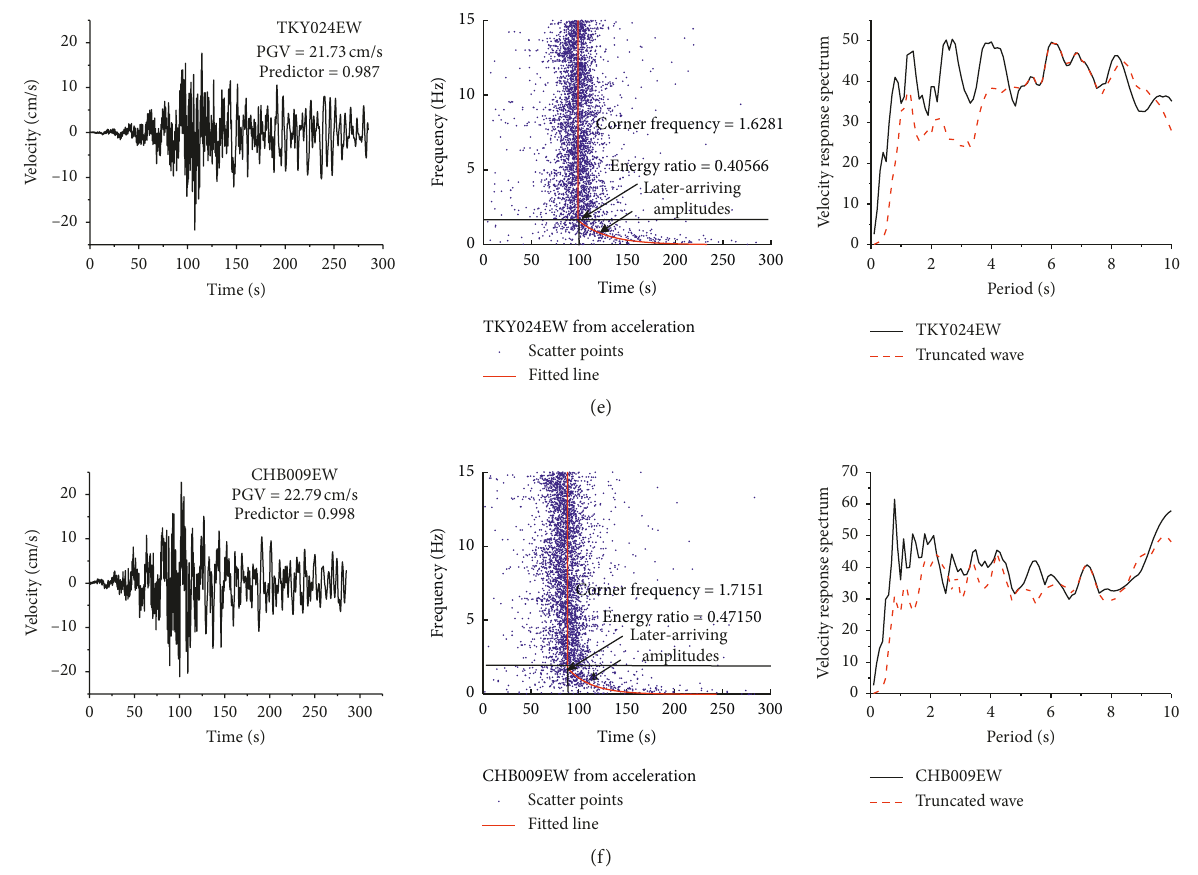
Figure 8: Six samples of the positive records. To better understand the effects of later-arriving amplitudes on long-period properties, each record has three subplots, including velocity-time history, velocity response spectrum, and envelope delay. A truncated wave is obtained in the light of envelope delays (detailed operations noted in this text) and the complete record represents the original record without removing the truncated wave. The records from (a) OSKH02NS, Western Tottori, M7.3; (b) HKD178NS, Tokachi Aftershock, M7.1; (c) HKD181NS, Tokachi Mainshock, M8; (d) OSK008NS, Southeast of Kii peninsula, M7.4; (e) TKY024EW, Tohuku, M9; (f) CHB009EW, Tohuku,